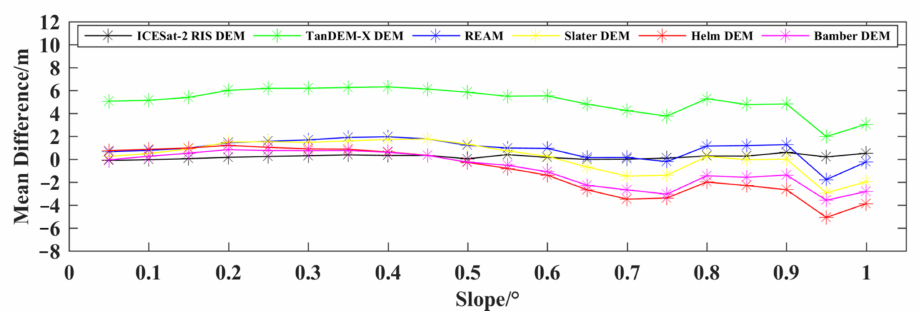
Figure 10. Mean difference between ICESat-2 RIS DEM as well as the five Antarctic DEMs and OIB elevations. The horizontal coordinate is the slope of the surface from 0 ◦ to 1 ◦ with an interval of 0.05 ◦